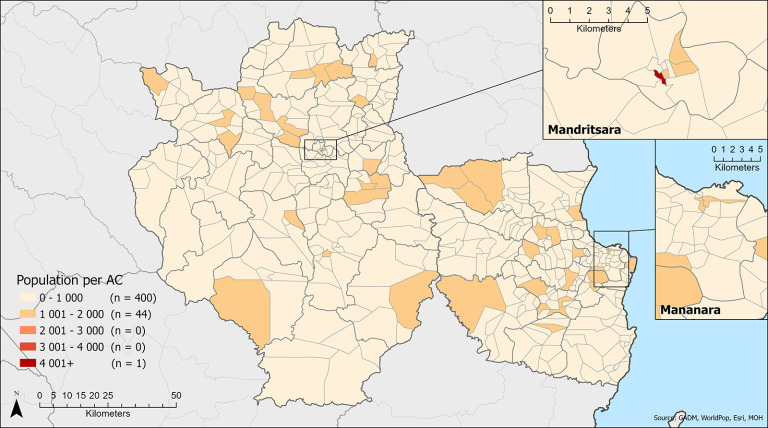
Population Coverage per ACs in MadagascarAbbreviation: ACs, agents communautaires (community health workers).